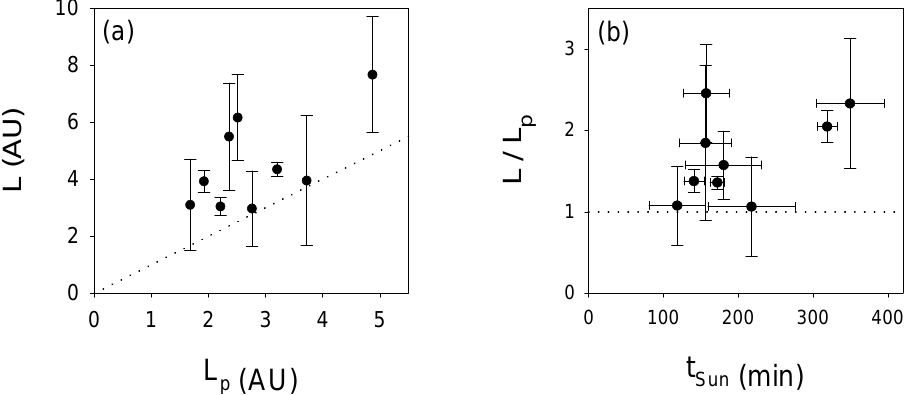
Fig. 5. Plot of (a) experimental path length versus the length L p of a Parker spiral connecting Ulysses to the Sun; and (b) the ratio L/L p versus t Sun . The dotted lines correspond to L = L p